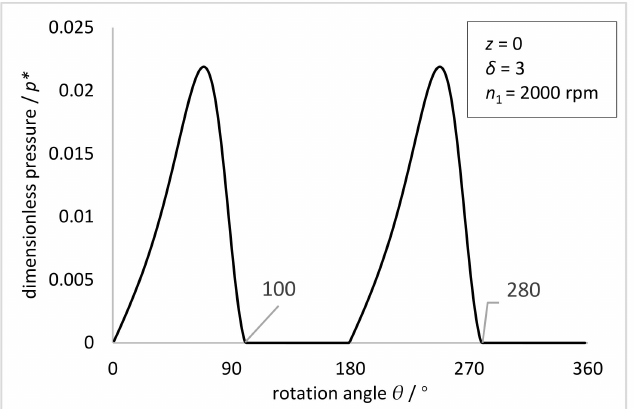
Figure 7. The dimensionless pressure distribution on the inner wall of the FS at z = 0 with the rotation angle θ ( z = 0, δ = 3, n 1 = 2000 rpm).